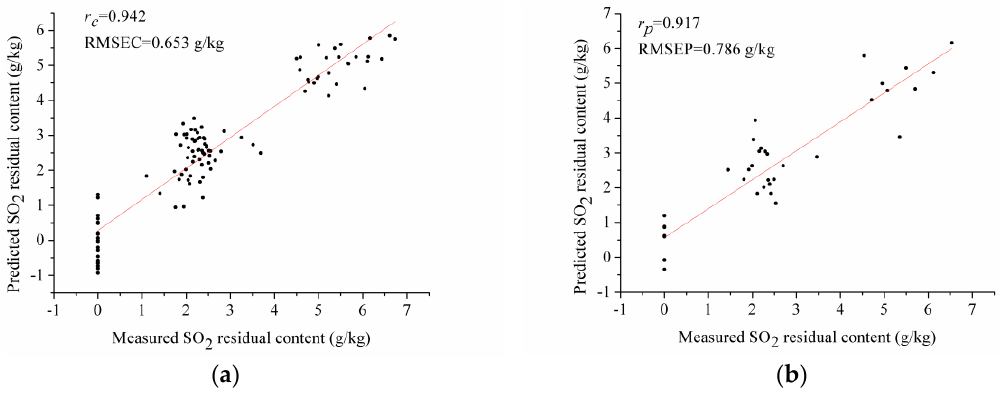
Figure 4. Prediction results of the calibration set ( a ) and the prediction set ( b ) of the Bw -PLSR